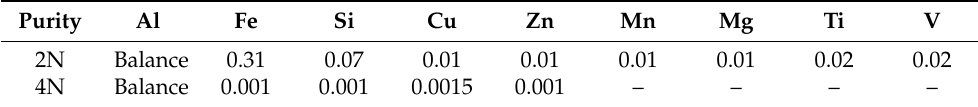
Figure 1. Schematic of the experimental procedure. Commercial pure 2N grade Al (cold-rolled AA1050) and high-purity Al (4N grade) were used as the base materials. Table 1 shows the chemical compositions of pure and high-purity Al. The dimensions of both plates were 100 mm in length, 100 mm in width, and 3 mm in thickness. The FSW tool consists of a planar shoulder with a diameter of 12 mm and a smooth cylindrical probe with a diameter and length of 4.0 mm and 2.8 mm, respectively. The tilt angle of the tool was 3 ◦ with respect to the normal direction. The FSW machine was operated in the displacement control mode with a constant penetration depth of 2.8 mm. For pure Al, butt welding was conducted under both low and high heat input conditions, where the tool rotational speeds were 800 and 1500 rev/min, respectively. In contrast, for high-purity Al, the tool rotational speed was 1500 rev/min. The tool traveling speed was set at 100 mm/min for both specimens. The specimens, including the exit hole, were fabricated using a wire-cut electric discharge machine and polished to a depth of 0.5 mm from the surface, where the shoulder-affected zone is located [25]. For optical microscopy observations and electron backscattering diffraction (EBSD) measurements, the polished specimen was electrically etched in a solution of HClO 4 : C 2 H 5 OH = 1 : 4 at ~0 ◦ C (ice bath) with an applied potential of 20 V. The EBSD measurements were carried out at 15 kV along the flow path of the marker material on the Al. The EBSD maps were obtained with a step size of 0.15–0.30 µ m. The grain size was calculated as a circle equivalent diameter of each grain in the EBSD map. The low-angle boundaries (LAB) and high-angle boundaries (HAB) were defined by misorientation angles ( θ ) of 2 ◦ < θ < 15 ◦ and θ > 15 ◦ , respectively. To characterize the grain structure development across the transition from the unwelded to the welded zone, an EBSD measurement position in a direction parallel to the welding direction was defined as a function of the distance, x mm, from the center of the exit hole. The peak welding temperature during the FSW was measured using a K-type thermocouple placed on the bottom surface of the plates at the centerline. Table 2 lists the welding conditions and final grain sizes for pure and high-purity Al. The peak welding temperatures for pure Al at tool rotational speeds of 800 and 1500 rev/min were 523 (= T 800 ) and 629 K (= T 1500 ), respectively. For high-purity Al, the peak welding temperature at a tool rotation speed of 1500 rev/min was 465 K (= T 1500 ). It is noted that the temperature within the 4 mm diameter probe is almost equivalent to the peak temperature. In this study, the welding condition was defined as a ratio of peak temperature to melting point of 933 K [26]. Therefore, T 800 / T m and T 1500 / T m were 0.56 and 0.67 for pure Al, respectively. T 1500 / T m was 0.50 for high-purity Al. Table 1. Chemical compositions for pure and high-purity Al